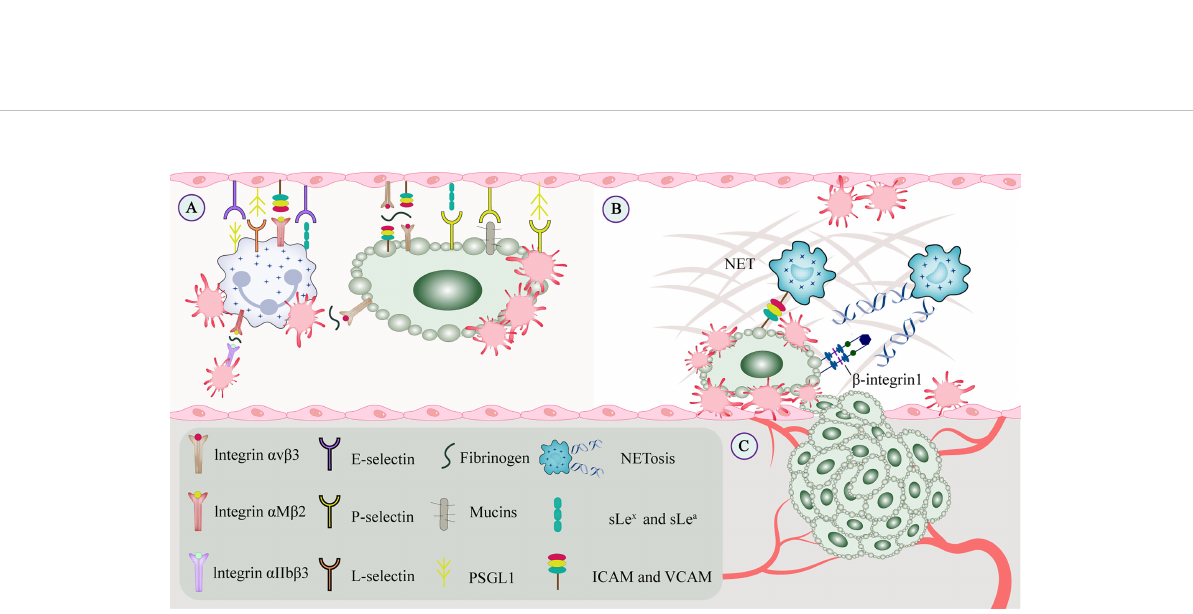
FIGURE 3 CTCs interact with constituents of the blood circulation. (A) Cell adhesion molecules mediate adhesion and signal transduction between cells and between cells and the extracellular matrix to promote tumor metastasis. Integrins and selectins play important roles in this process. On the one hand, selectins can bind to leukocytes or endothelial cells to enable and maintain cell rolling. On the other hand, GPVI and podoplanin can be involved in platelet-mediated tumor metastasis. (B) Platelets promote recruit neutrophils to generate extracellular traps, and NETs interact with CTCs to form a protective barrier that facilitates CTC extravasation and the formation of metastatic niches. CTCs promote platelet-induced NETosis, associated with increased complications such as tumor-associated thrombosis, venous thromboembolism, and tumor metastasis. (C) Growth factors secreted by platelets (such as VEGF, PDGF, and FGF) bind to the corresponding receptors (such as integrins, Notch signaling receptors), which may regulate tumor angiogenesis and vascular integrity. CTC, circulating tumor cell; EGF, epidermal growth factor; GP, glycoprotein; NET, neutrophil extracellular trap; PDGF, platelet-derived growth factor; VEGF, vascular endothelial growth